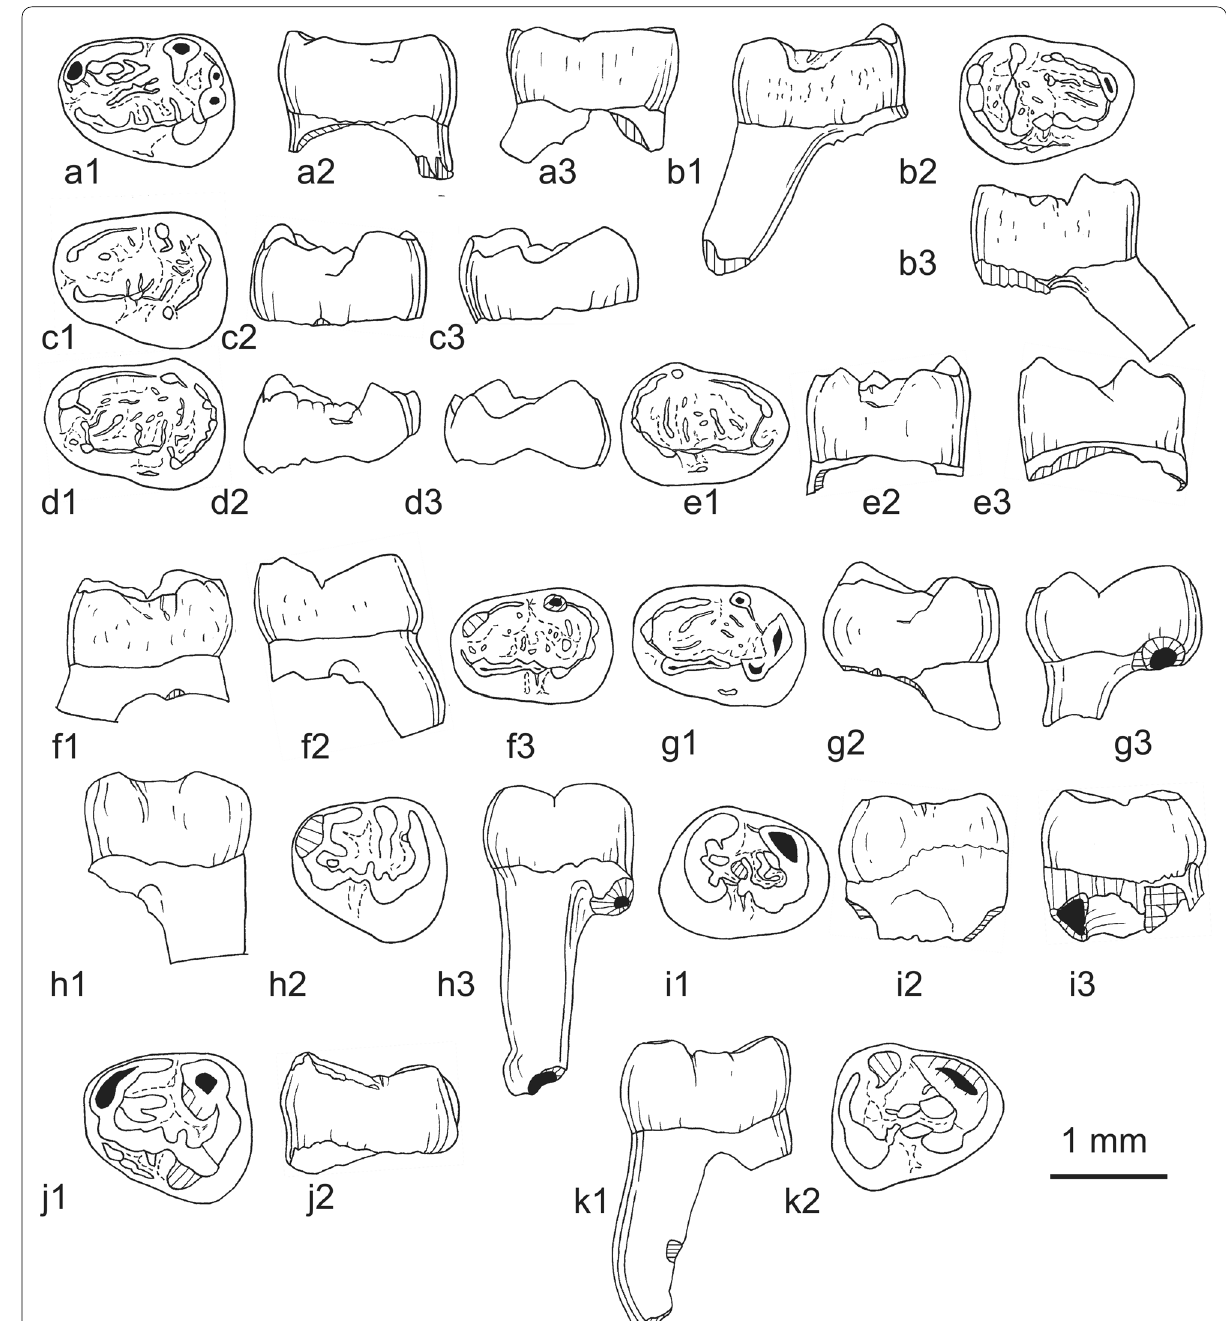
Fig. 47 Lower dp4 and p4 of ? Protadelomys maximini Escarguel, 1998 from Saint‑Maximin (Gard). a SMX1‑201, left dp4; a1, occlusal view; a2, buccal aspect; a3, lingual aspect. b SMX1‑203, right dp4; b1, buccal aspect; b2, occlusal view; b3, lingual aspect. c : SMX1‑202, left dp4; c1, occlusal view; c2, buccal aspect; c3, lingual aspect. d SMX1‑206, left dp4; d1, occlusal view; d2, buccal aspect; d3, lingual aspect. e SMX2‑204, right dp4; e1, occlusal view; e2, buccal aspect; e3, lingual aspect. f SMX2‑205, left dp4; f1, buccal aspect; f2, lingual aspect; f3, occlusal view. g SMX3‑26, left p4; g1, occlusal view; g2, buccal aspect; g3, lingual aspect. h SMX1‑209, left p4; h1, buccal aspect; h2, occlusal view; h3, lingual aspect. i SMX1‑208, right p4; i1, occlusal view; i2, buccal aspect; i3, lingual aspect. j : SMX1‑210 left p4; j1, occlusal view; j2, buccal aspect. k : SMX2‑206, right p4; k1, buccal aspect; k2, occlusal view. Scale bar 1 =